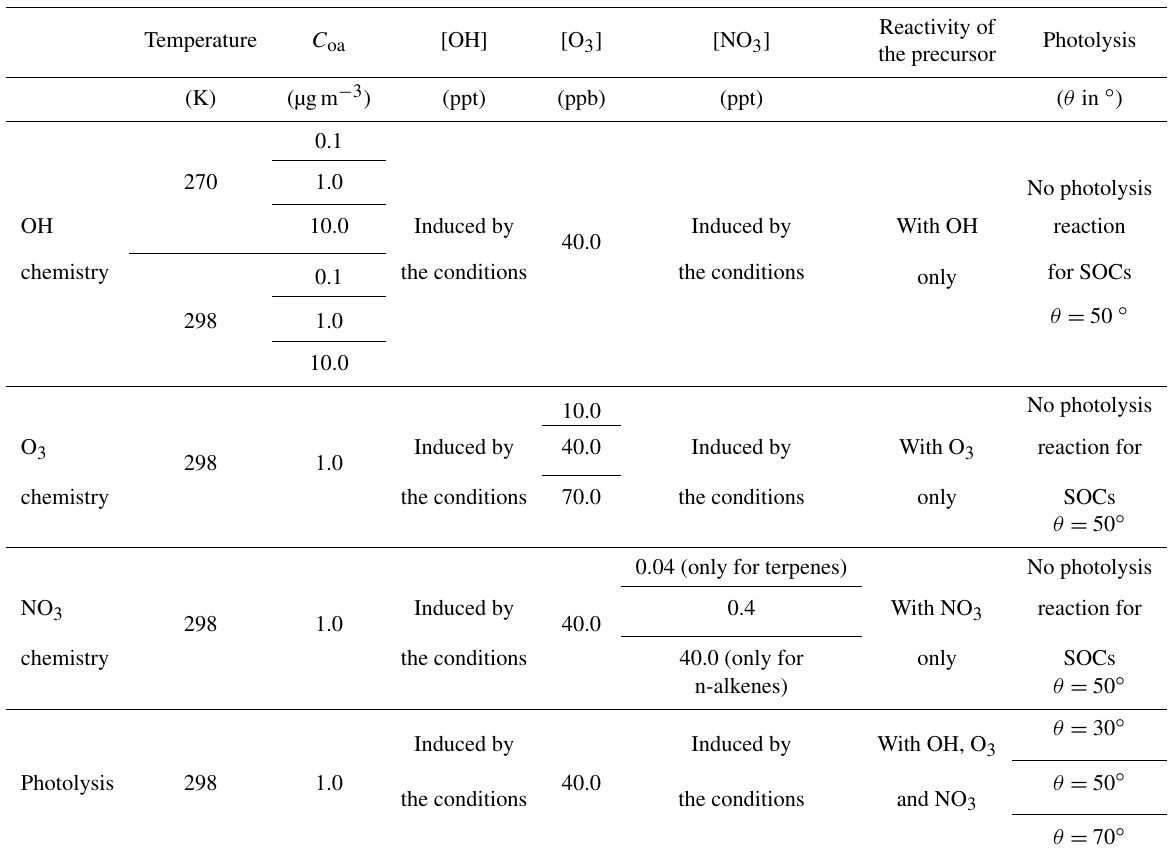
Table 3. Simulation conditions of the learning